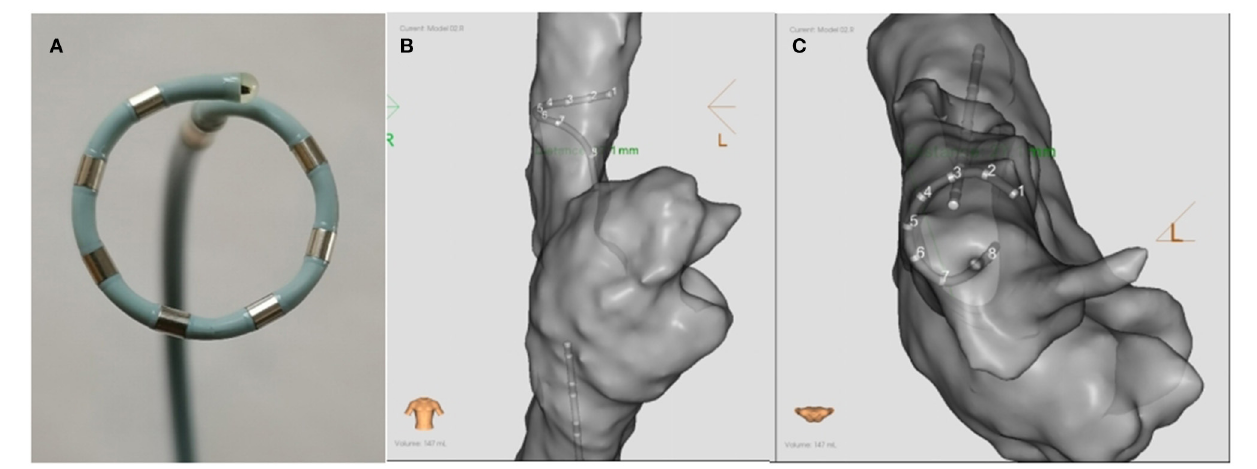
FIGURE 1 | The schematic diagram (A ) and the ablation positions (B,C) of the PFA catheter. (A) The catheter was an alternating current, bipolar, multi-electrode circular 6F catheter with seven electrodes. The diameter of the loop was 15mm, and the inter-electrode distance was 4mm. (B,C) show the ablation postions of PFA in the SVC in the anterior-posterior and superior position, respectively. PFA, Pulsed field ablation.